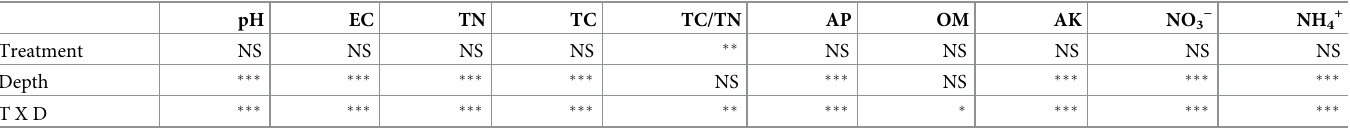
Table 2. Multivariate ANOVA for the effects of soil depth, and different fertilizers on soil biochemical properties.